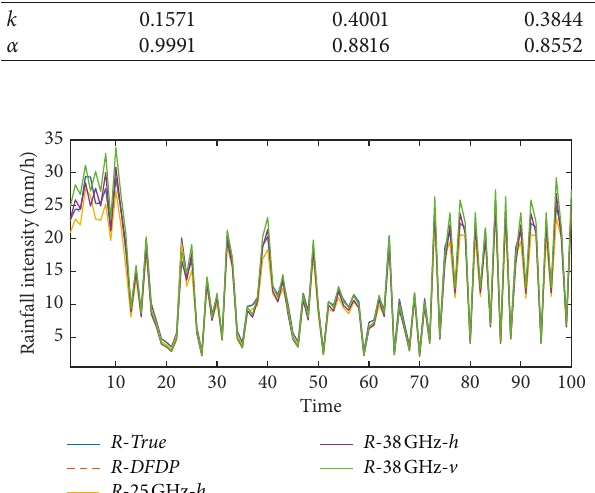
Figure 8: Retrieval results of R (first group). R - True represents the true rainfall intensity. R -DFDP represents the rainfall intensity calculated by the first method based on the DSD while R -25 GHz-h, R -38GHz-h, and R -38 GHz-v represent the rainfall intensity cal- culated by the second method of the ITU model in different fre- quencies and polarizations.